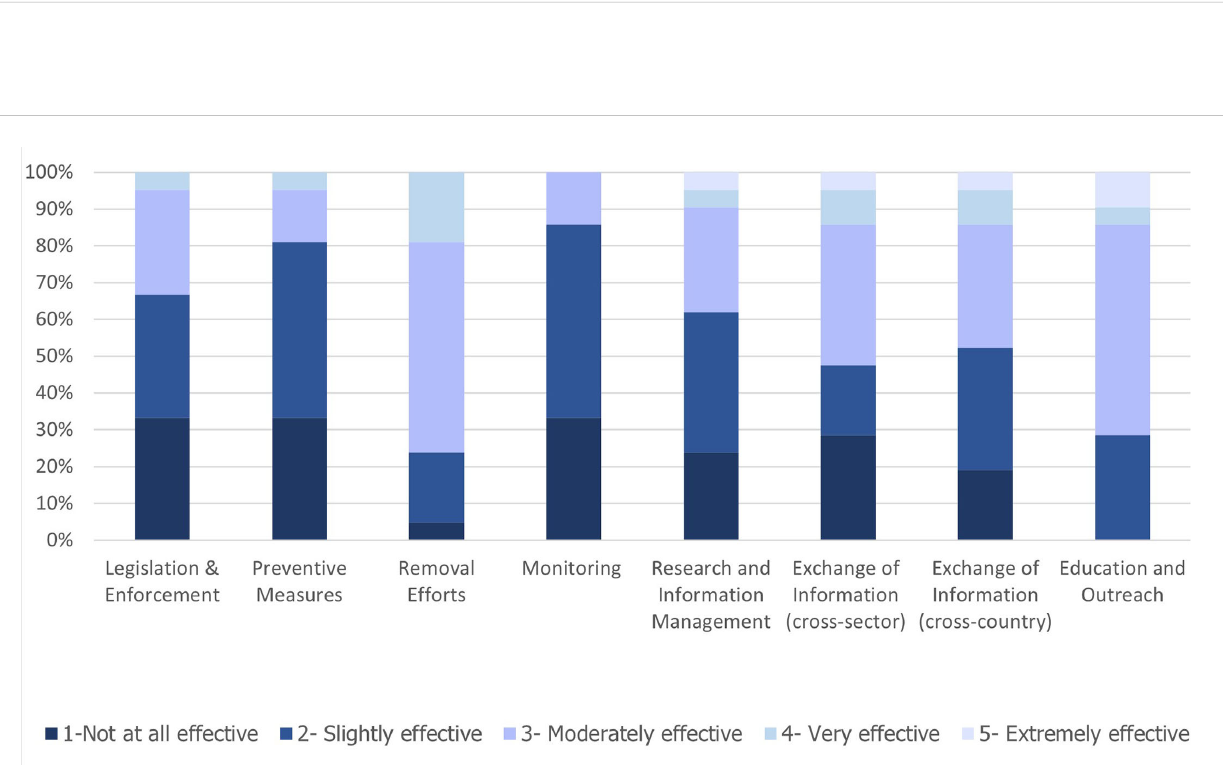
FIGURE 5 Professional opinions on effectiveness of marine litter management activities in the Windward